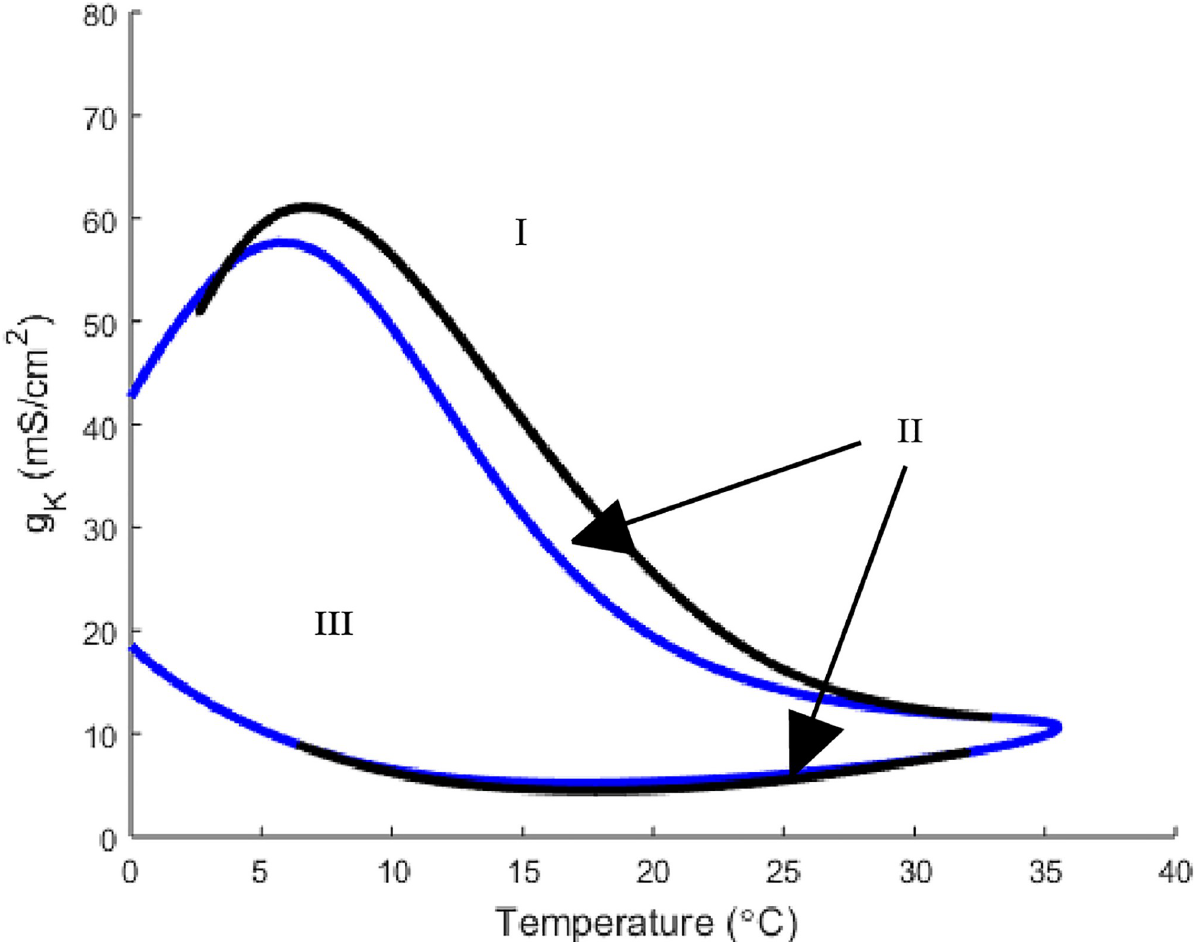
Fig 9. A two parameter bifurcation of the relationship between temperature and g K . Curve color and labeled regions are identical in meaning to = those in Fig 1. Here g m 8